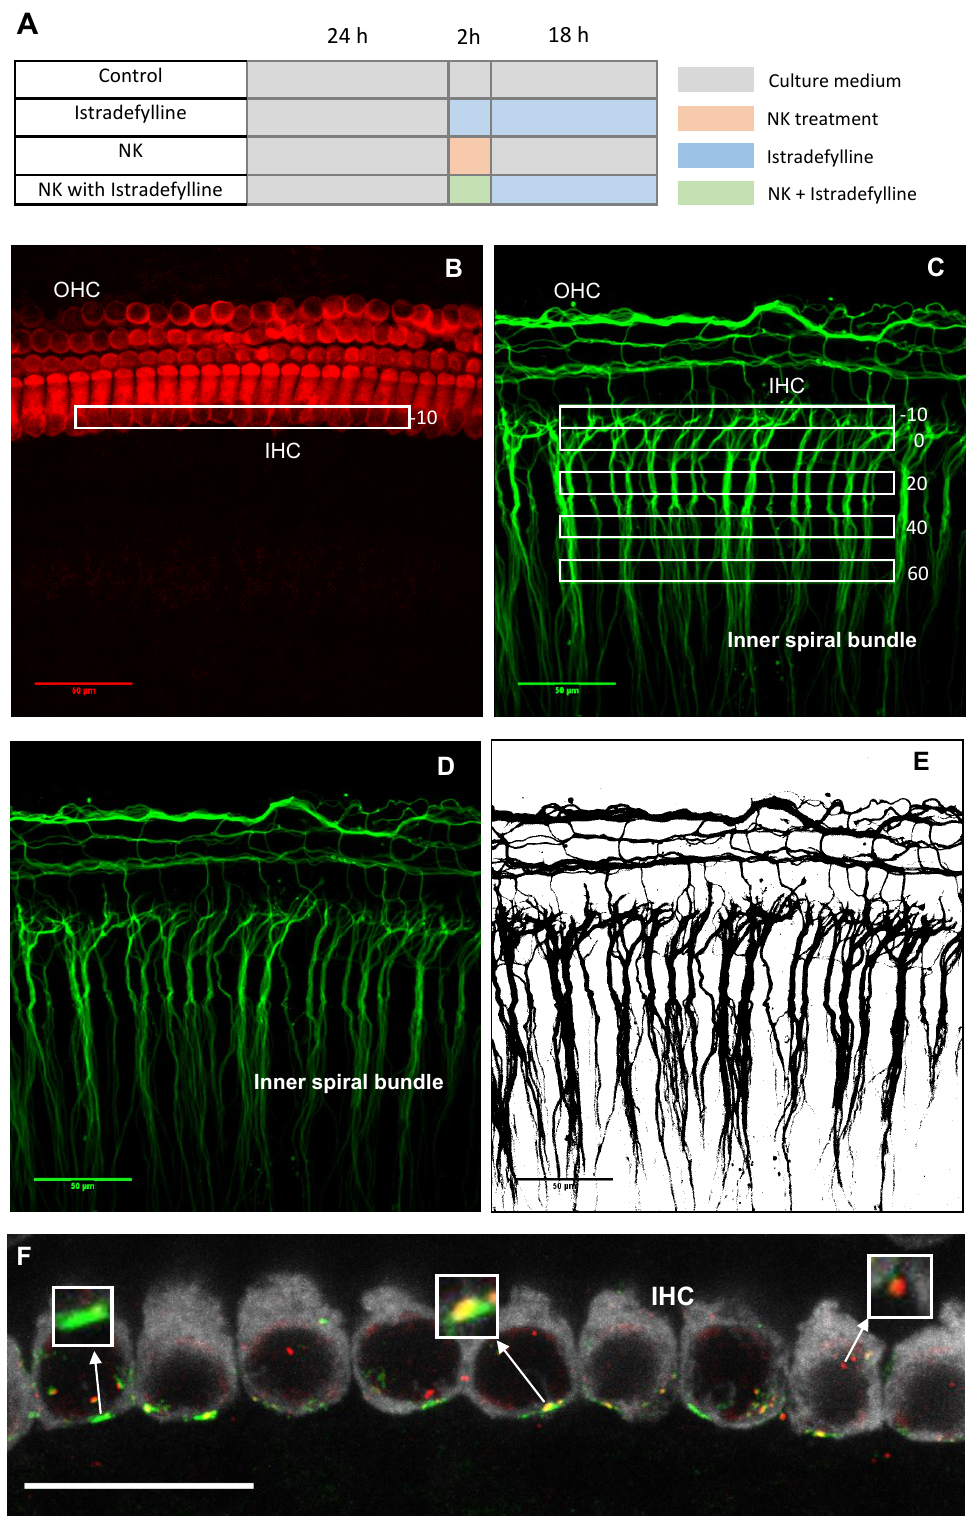
Figure 1. ( A ) Outline of the study. ( B ) The regions of interest ( − 10 to + 60 µ m) at the inner hair cell level (myosin VIIa immunolabelling) and ( C ) at the inner spiral bundle level ( β -tubulin immunolabelling) in organotypic tissue cultures of the P6 Wistar rat cochlea. ( D ) An original projected image of neurites immunolabelled with β -tubulin and ( E ) the converted binary image used for data analysis. ( F ) An image of the inner hair cell synaptic region: a paired synapse (yellow), orphan postsynaptic density protein (PSD95, green) and orphan presynaptic ribbon (CtBP2, red). Scale bars ( B – E ), 50 µ m; ( F ) 20 µ